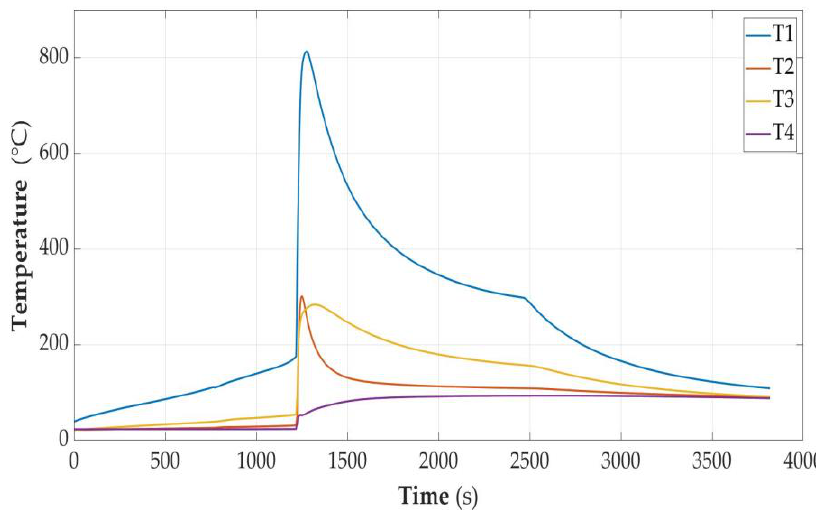
Figure 9. Graphs of temperature changes during heating and energy supplied to the cell module in the SOC > 100% state.